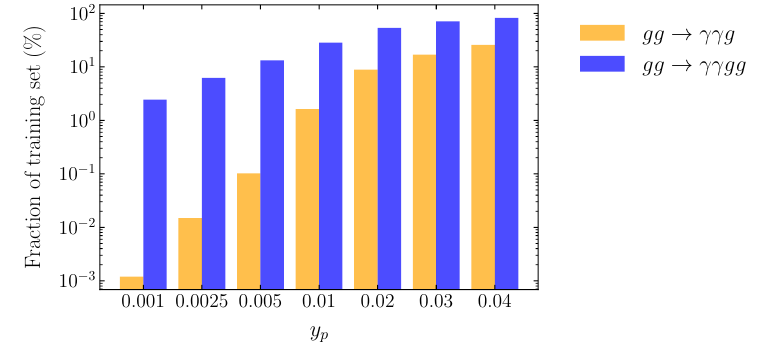
Figure 11. Proportion of the training dataset in the divergent region, R div , as a function of y p for the 2 → 3 and 2 → 4